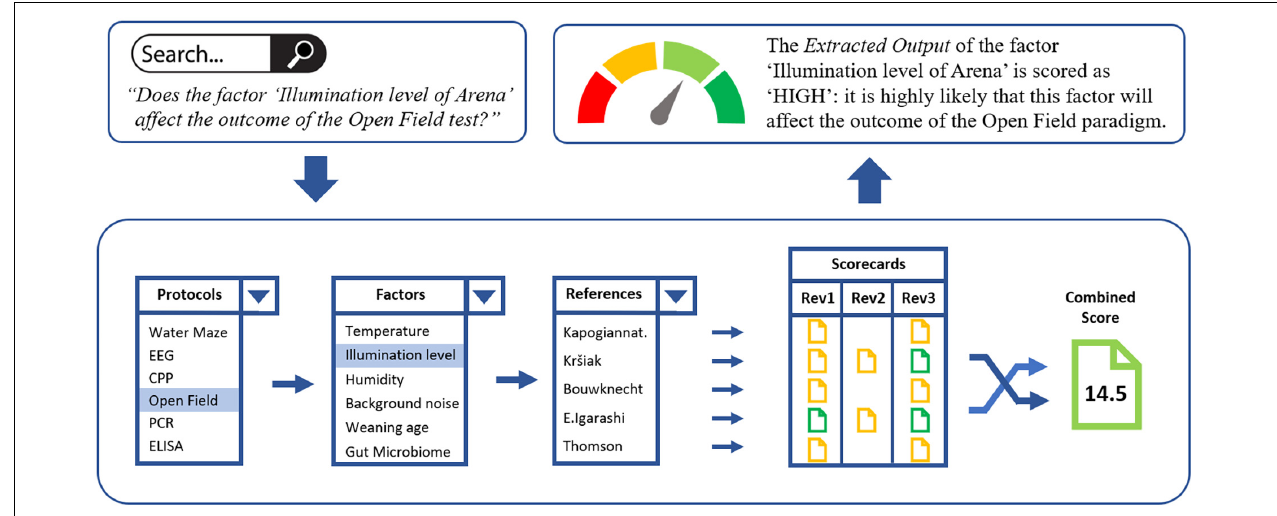
FIGURE 3 | The “Open Field” protocol example, demonstrating how the different back-end functionalities of PEERS will translate into the “Extracted Output,” presented to PEERS users. A search query for a specific factor/protocol will lead to the selection of all relevant references from the PEERS database dealing with the factor of interest (e.g., the “illumination level of the arena”). Based on the scorecards for these references the combined score is calculated which translates into the overall extracted output for the selected factor/protocol combination. This status is then presented to the user. Users also have access to all scorecards to understand how the overall grading of evidence was